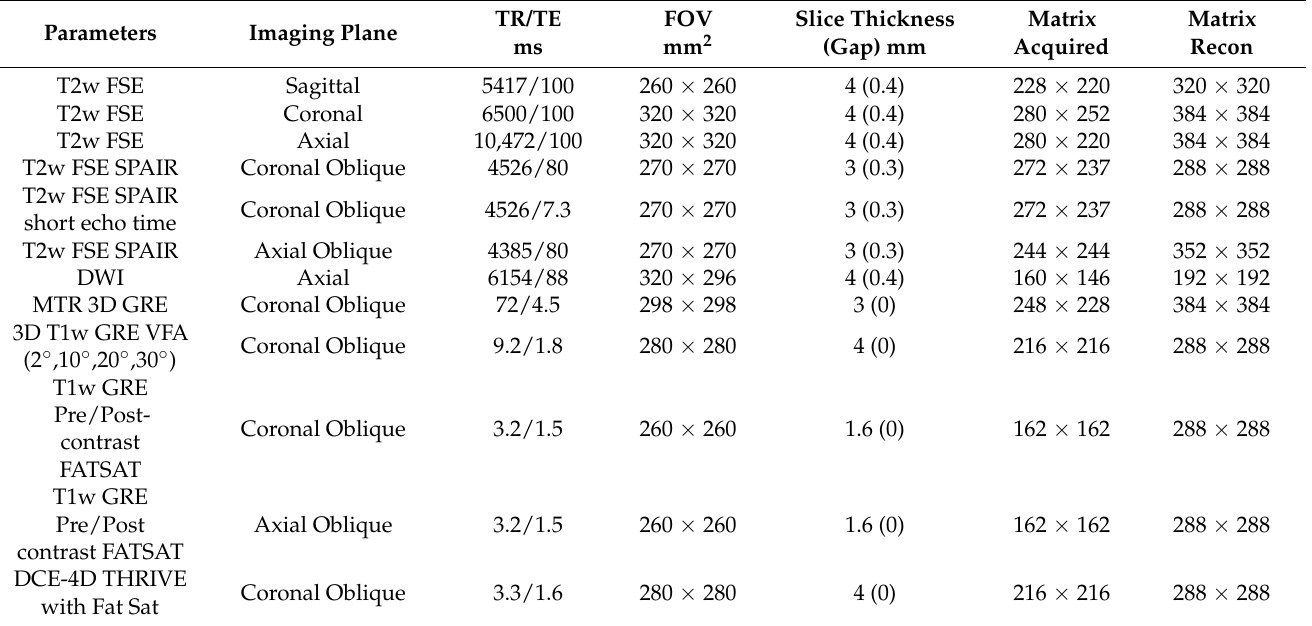
Table A3. MRI sequence parameter information for 3.0 T Philips scanners (Nottingham and London